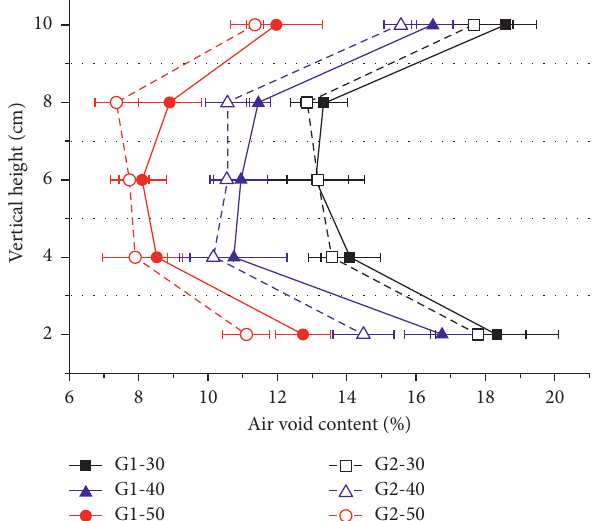
Figure 6: Air void distribution under the vertical